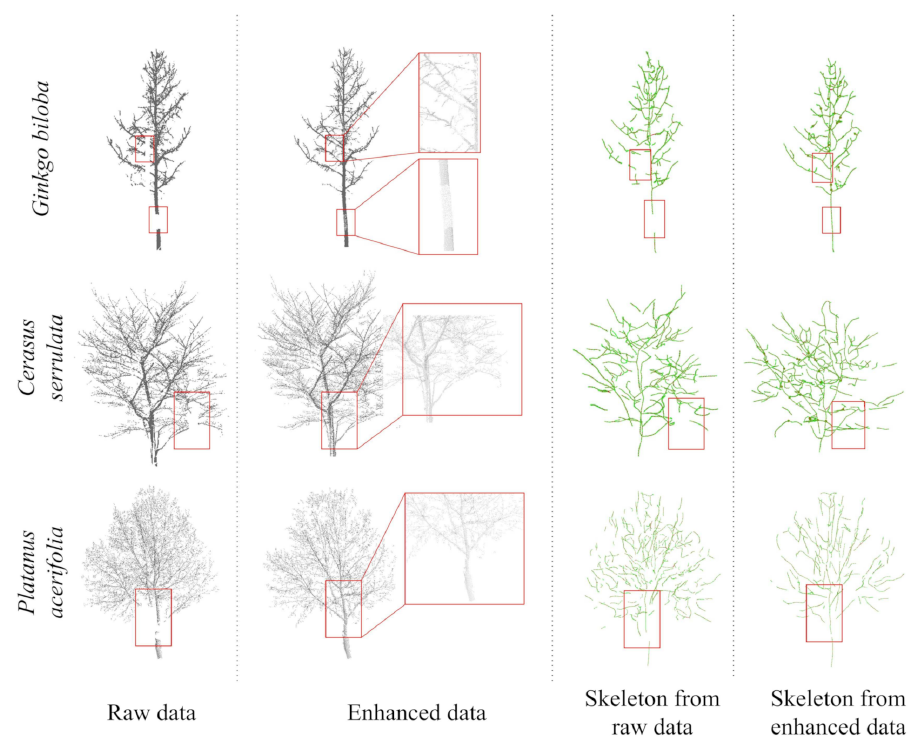
Figure 8. Schematic diagram of point cloud restoration of Ginkgo biloba , Cerasus serrulata and Platanus acerifolia